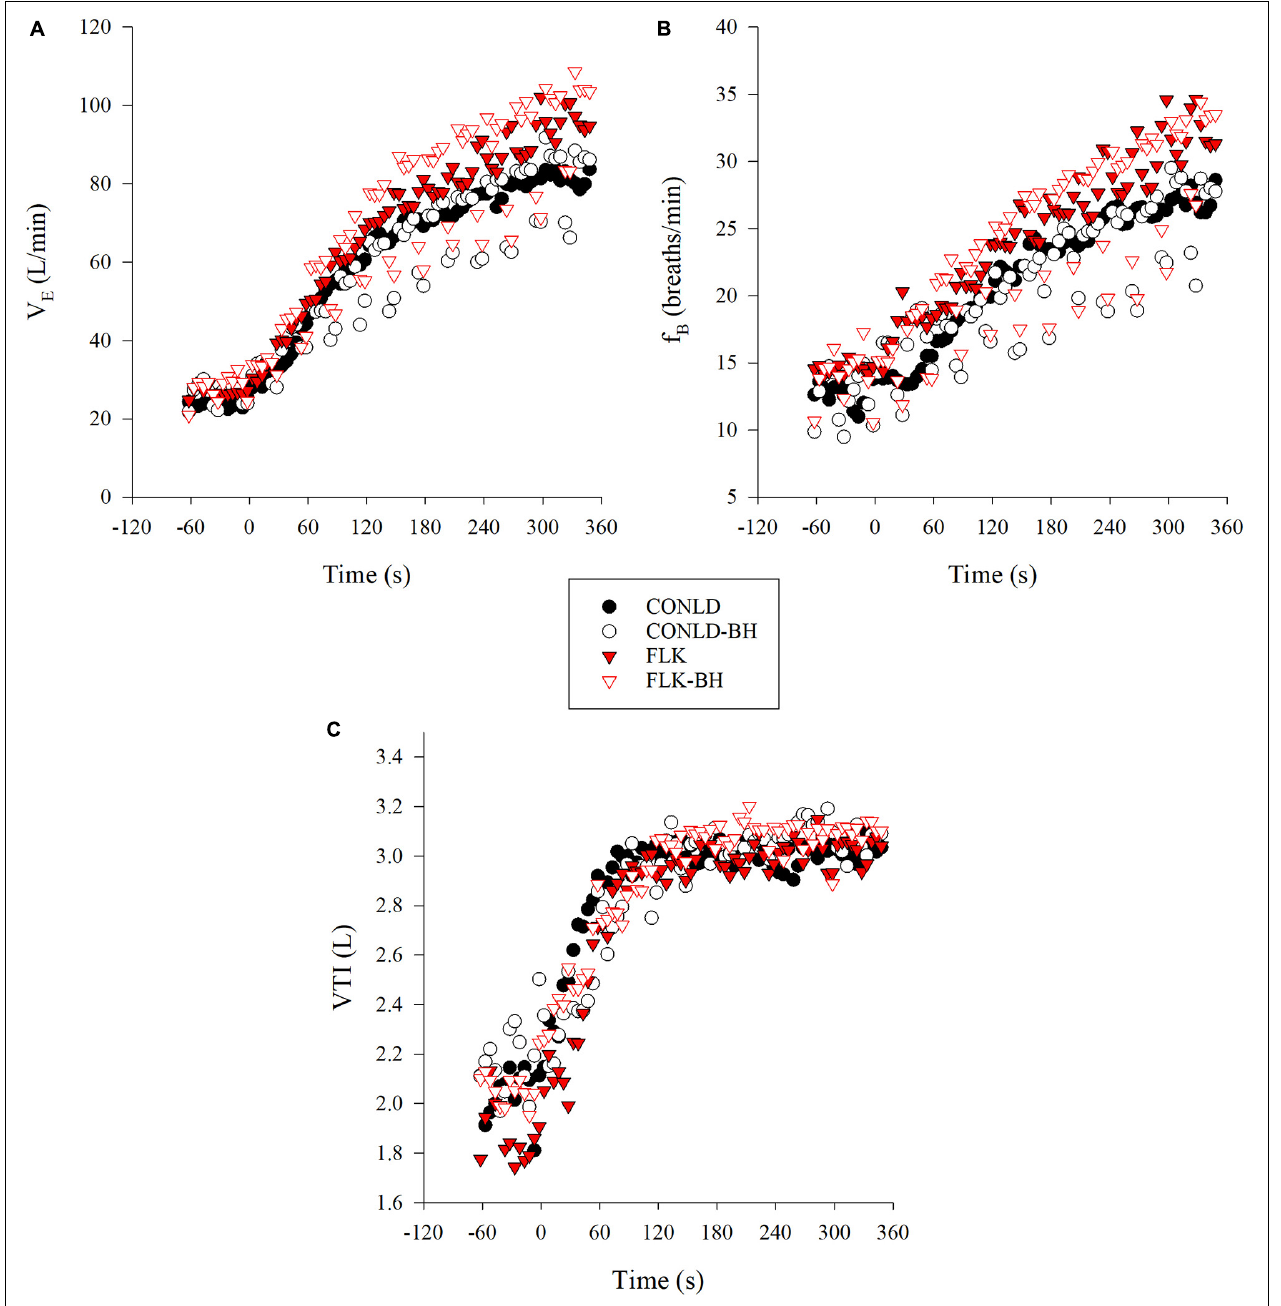
FIGURE 1 | Breathing data during CONLD (filled circles), CONLD-BH (open circles), FLK (filled red triangles), and FLK-BH (open red triangles). (A) Minute ventilation (V E ), (B) frequency of breathing (f B ), and (C) inspiratory tidal volume (VTI). Time 0 marks the start of the exercise transition. Data were interpolated from breath-by-breath to second-by-second and 5 s averaged for graphical